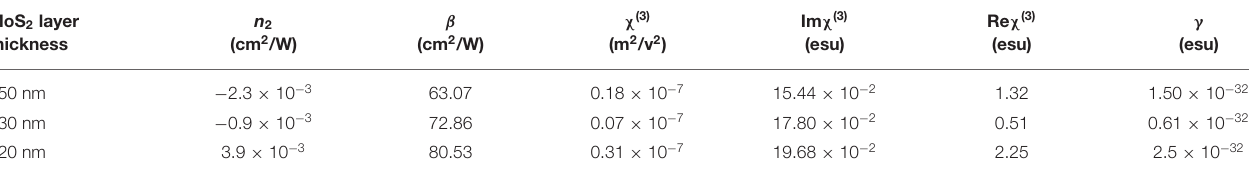
TABLE 1 | Non-linear optical parameters of the MoS 2 layers with different thicknesses.